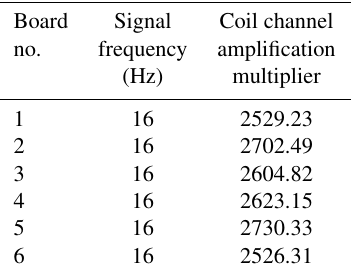
Table 2. Coil channel amplification multiplier